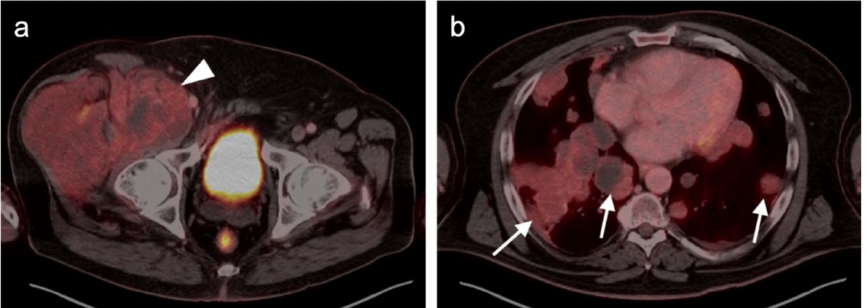
Figure 31. Myxoid chondrosarcoma. ( a ) An axial FDG PET-CT image of the pelvis demonstrates a large, moderately hypermetabolic soft tissue mass arising between muscle groups of the right anterior pelvis (white arrowhead). ( b ) An axial FDG PET-CT image of the chest shows multiple hypermetabolic lung metastases (white arrows), some with central